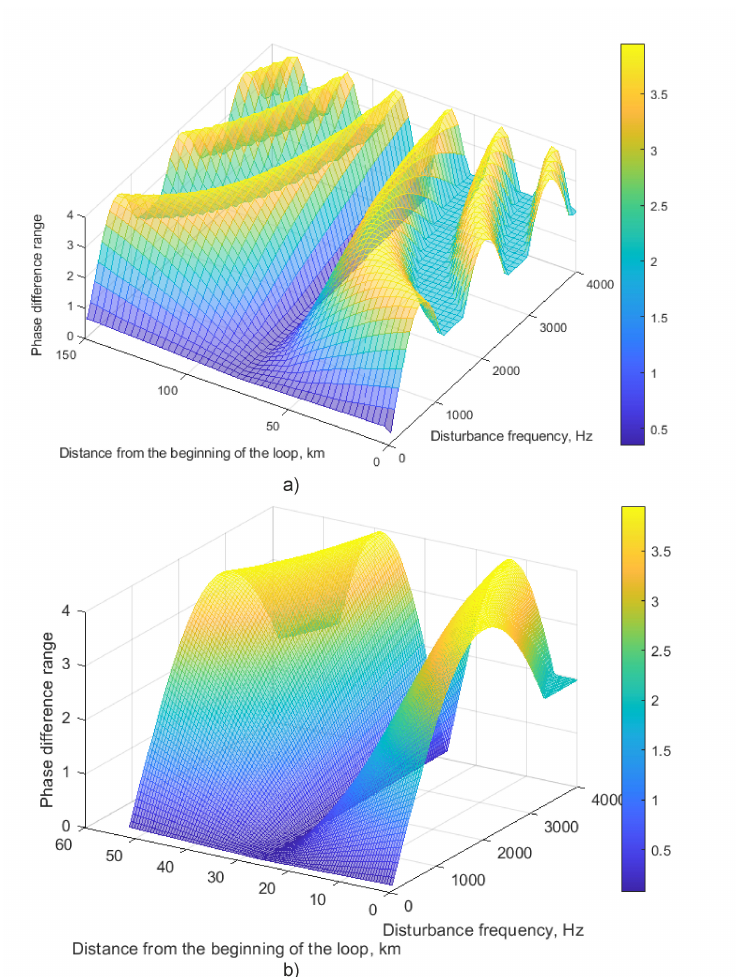
Figure 11. Phase different range depending on disturbance frequency and position: ( a ) L = 150 km, ( b ) L = 51.8